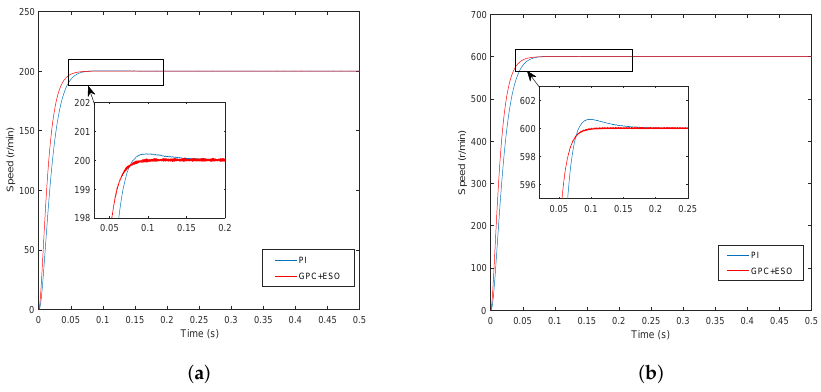
Figure 2. Simulation curves of speed response. ( a ) n = 200 r/min; ( b ) n = 600